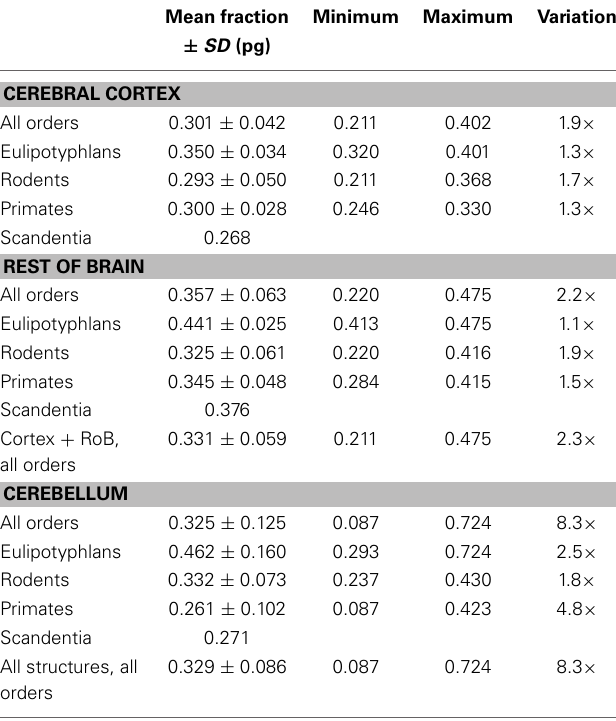
Table 4 | Predicted average glial mass fraction in mammalian brain